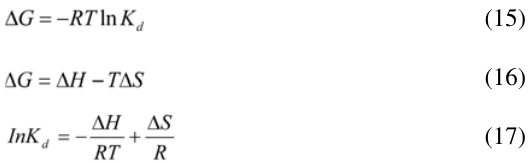
The increase in removal percentage at a higher pH on value can be explained by the precipitation of Cr(OH) 3 the borax sludge by surface adsorption. 9 The probable re- moval mechanism of Cr(III) by borax sludge can be ex- plained in three steps: (1) the dissolution of dolomite and tincalconite in the borax sludge and the formation of Ca 2+ , preci- Mg 2+ and Na + cations; (2) the formation of Cr(OH) 3 pitate; (3) the cations on the adsorbent (Ca 2+ , Mg 2+ and Na + ) are exchanged with Cr 3+ According to the adsorption . results, the steps of waste dissolution and Cr(OH) preci- 3 pitation progress successfully in the experiments by in- creasing the pH values. This indicates that the adsorption mechanism proceeds well in an alkaline environment.